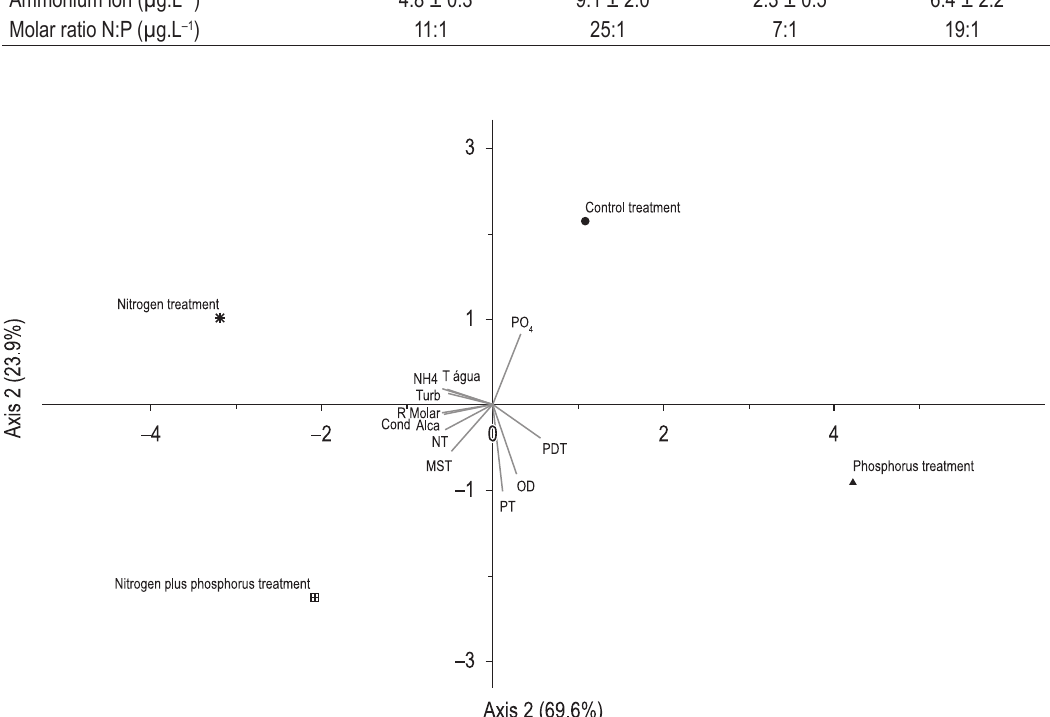
Figure 3. Biplot of principal component analysis with ordering the treatments studied in relation to abiotic parameters. Orthophosphate = PO4; Total dissolved phosphorus = PDT; Total phosphorus = PT; Dissolved oxygen = OD; Total suspended material = MST; Total nitrogen = NT; Alkalinity = Alca.; Conductivity = Cond.; Molar ratio N:P = R molar; Turbidity = Turb.; Ammonium ion = NH4; Water temperature = T